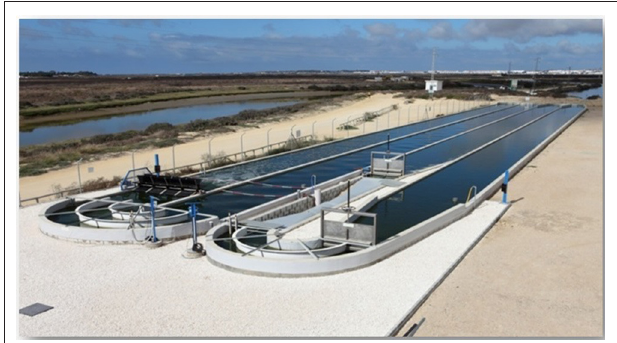
FIGURE 3 | Image of raceway reactors operated by FCC AQualia in ALLGAS project for wastewater treatment and nutrients recovery using microalgae. Left, a regular raceway reactor, Right, the LEAR